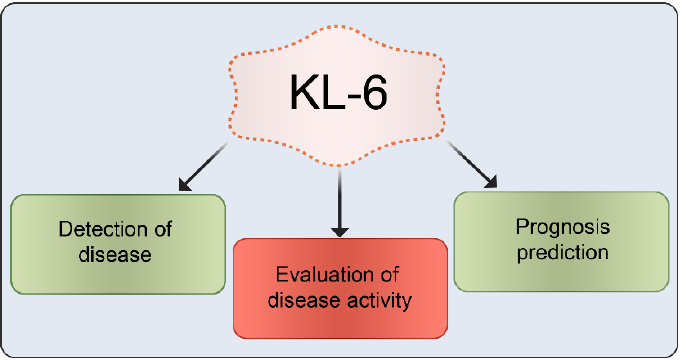
Figure 2. The three main areas of applicability of KL-6 in managing the SARS-COV-2